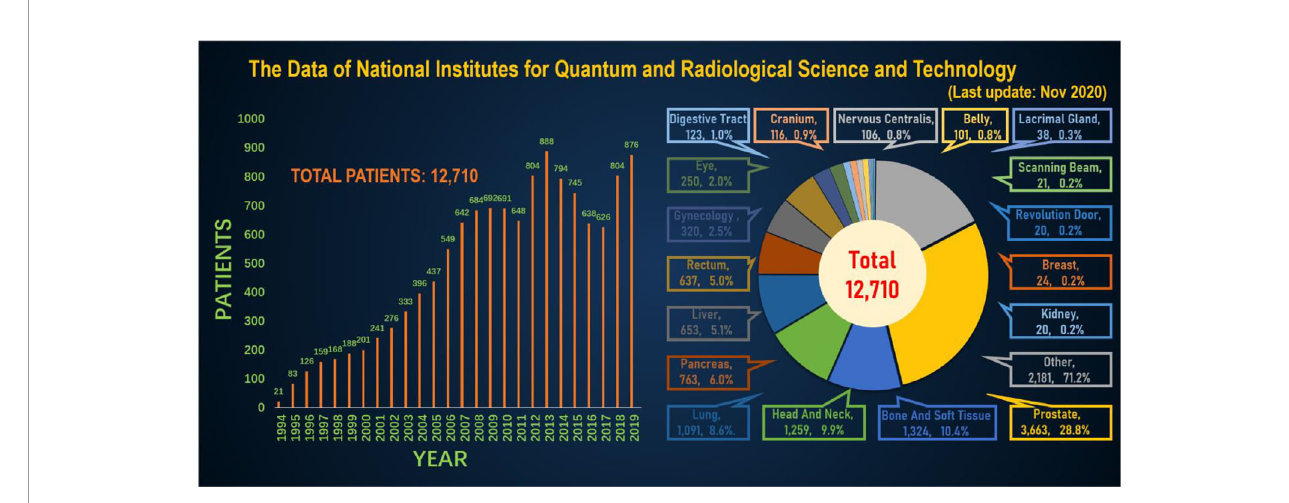
FIGURE 4 | The annual number of patients treated with heavy ions and the distribution of heavy ion radiotherapy in Japan ’ s NIRS for various cancer